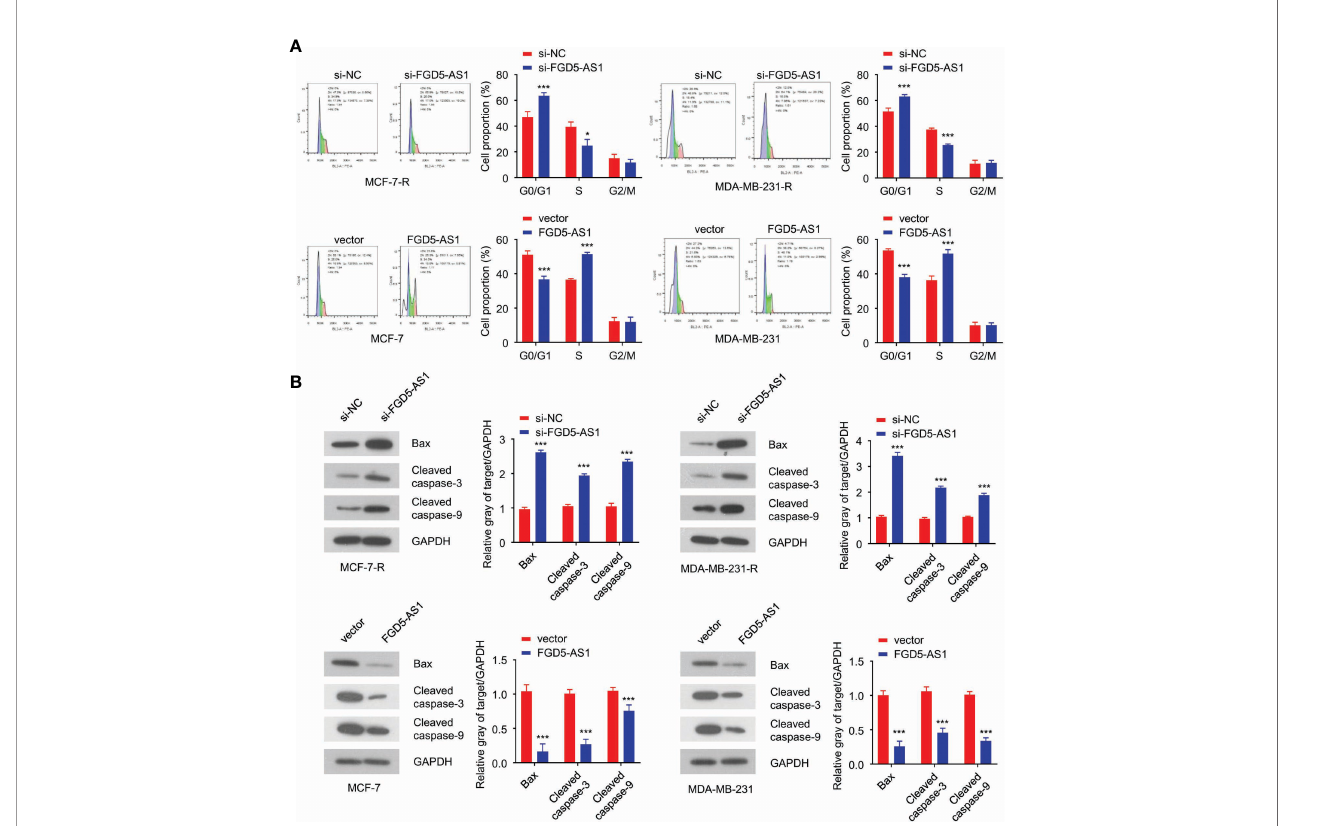
FIGURE 3 | FGD5-AS1 depletion triggers cell apoptosis in BC cells. (A) fl ow cytometry analysis indicated downregulation of FGD5-AS1 arrested MCF-7-R or MDA- MB-231-R cells at G0/G1and induced much more apoptosis after treated with 2 Gy of ionizing radiation. Meanwhile, overexpression of FGD5-AS1 arrested MCF-7 and MDA-MB-231 at the S phase, and less apoptosis was observed after ionizing radiation. (B) WB showed that knockdown of FGD5-AS1 signi fi cantly increased the protein levels of Bax, cleaved caspase-3, and caspase-9 in MCF-7-R or MDA-MB-231-R cells treated with 2 Gy of ionizing radiation. Overexpression of FGD5- AS1 signi fi cantly decreased the protein levels of Bax, cleaved caspase-3, and caspase-9 in MCF-7-R or MDA-MB-231-R cells treated ionizing radiation. Intra-group comparison *p < 0.05, ***p <